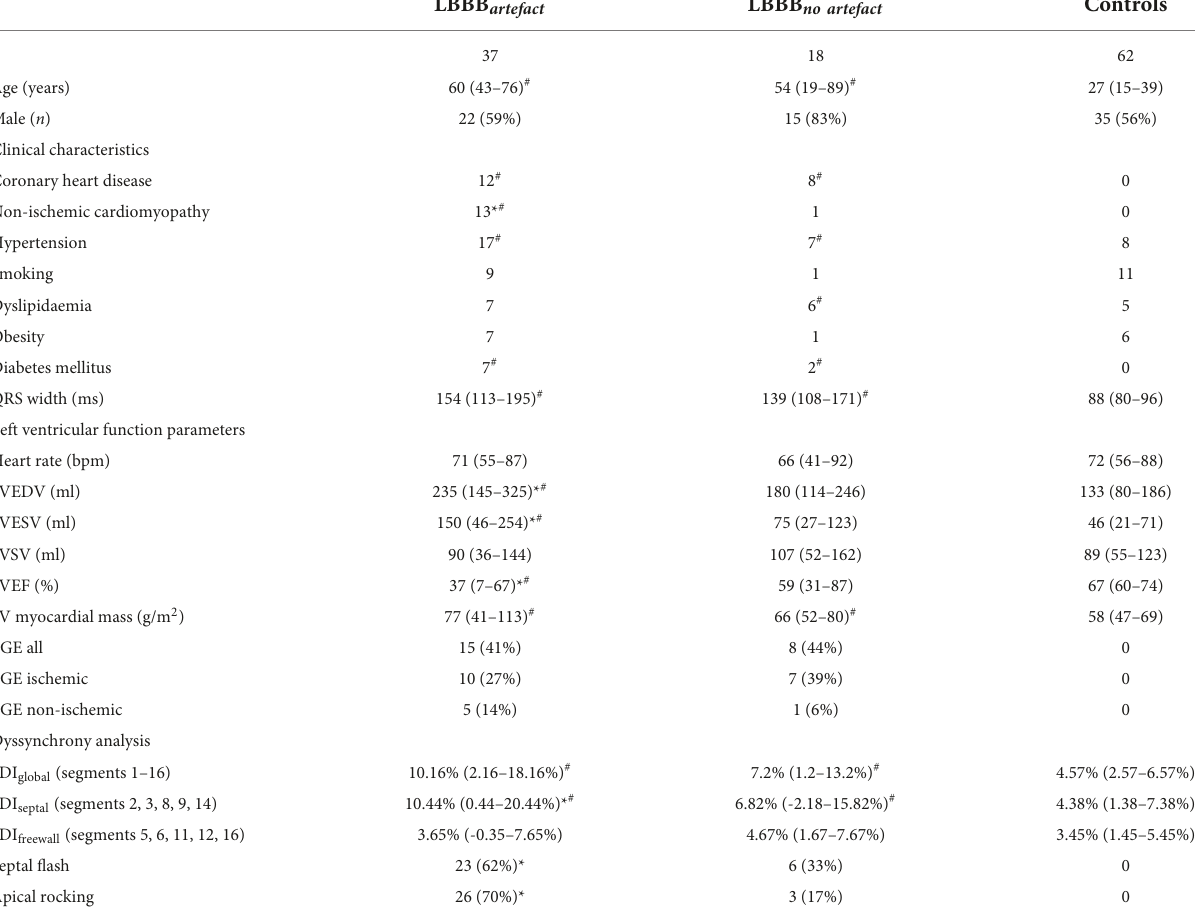
Overviewofdemographics,clinicalcharacteristicsandimaging-basedparametersofpatients(LBBB artefact /LBBB no artefact )andcontrols. The upper part of the table shows demographics, clinical characteristics, left ventricular function parameters and LGE pattern (ischemic/non-ischemic) for both groups of LBBB and healthycontrols.ResultsforanalysisofmechanicaldyssynchronybasedonstrainanalysisandqualitativeanalysisofCINEimagesareshowninthelowerpartofthetable. Valuesarepresentedasmedian(median ± interquartilerange),* p < 0.05vs.LBBB no artefact , # p <